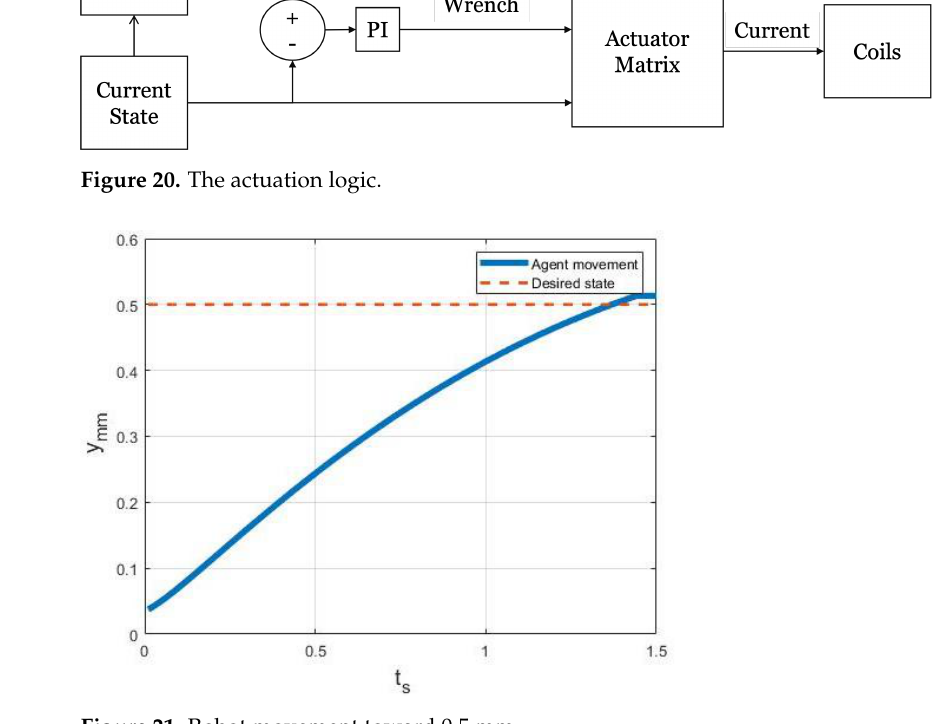
Figure 21. Robot movement toward 0.5